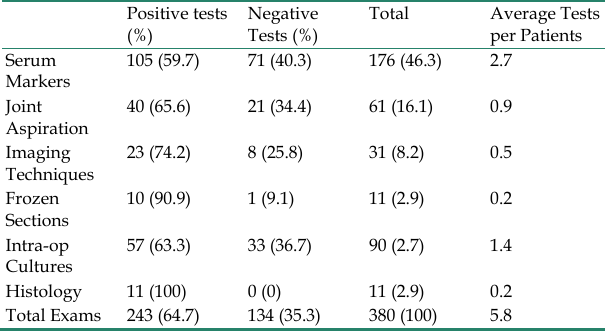
Table 2. Type, number and results (positive or negative) tests performed in patients eventually treated as infected (Group A, n